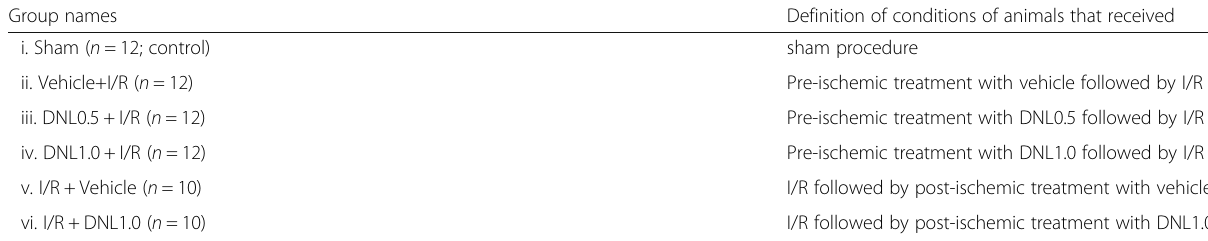
Table 2 Group names and definition of the conditions used to treat the various experimental groups of cells or animals. In vivo eletrophysiological and histopathological experiments a Group names